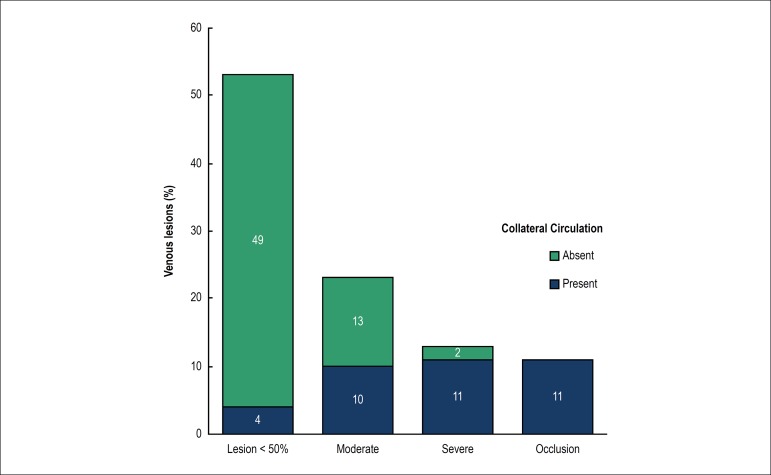
Distribution of the four types of venous lesions and their
associations with the presence of collateral circulation.